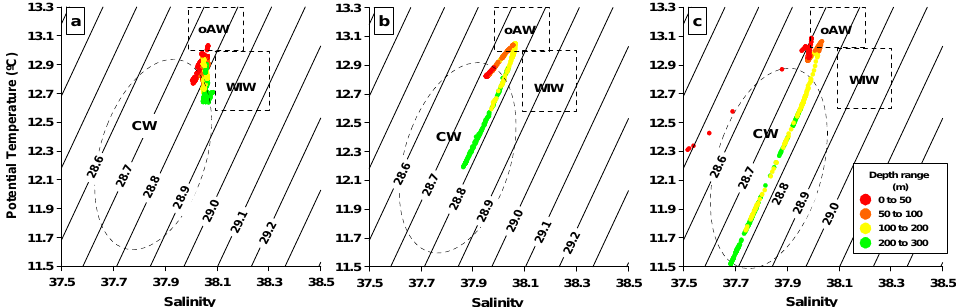
Fig. 10. T/S diagrams from selected CTD profiles conducted at the CX station in the Cap de Creus Canyon (a) storm setup period (ensemble of 12 CTD casts from 11 to 12/03 2011); (b, c) individual CTD casts during the peak and aftermath of the storm respectively (see the text and Fig. 5 for details). CW=coastal waters; WIW=Western Intermediate Waters; oAW=old Atlantic Water; LIW=Levantine Intermediate Water.